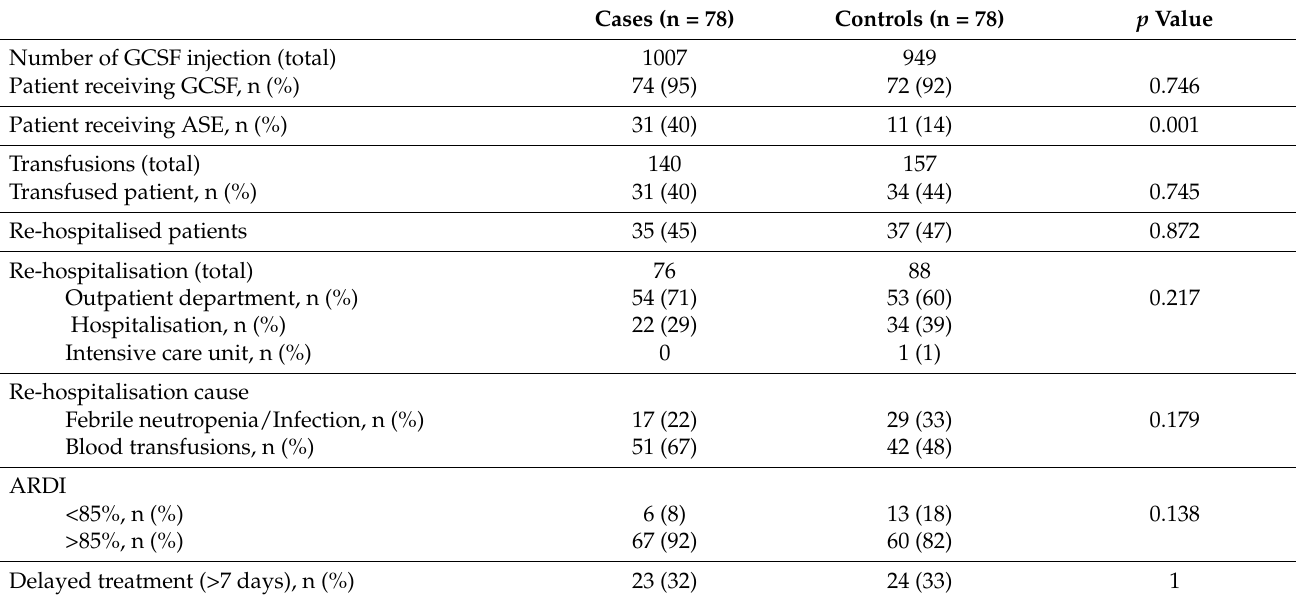
Table 5. Outcomes in the cases and the controls